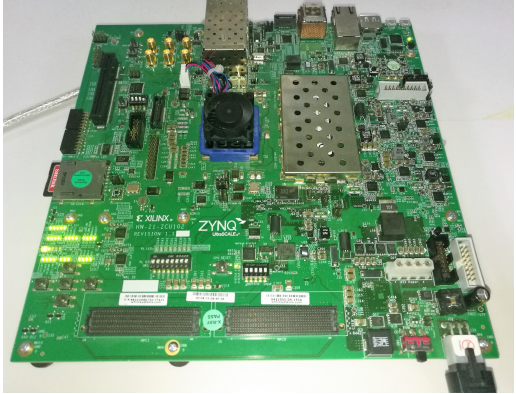
Figure 16. The ZCU102